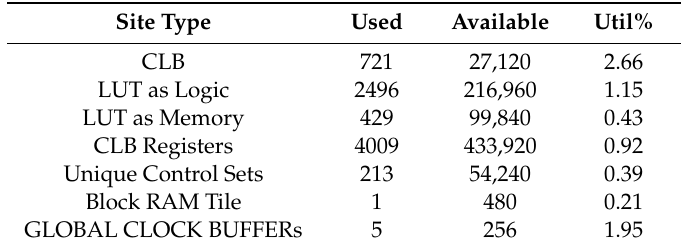
Table 5. Resource utilization report of phase rotation.